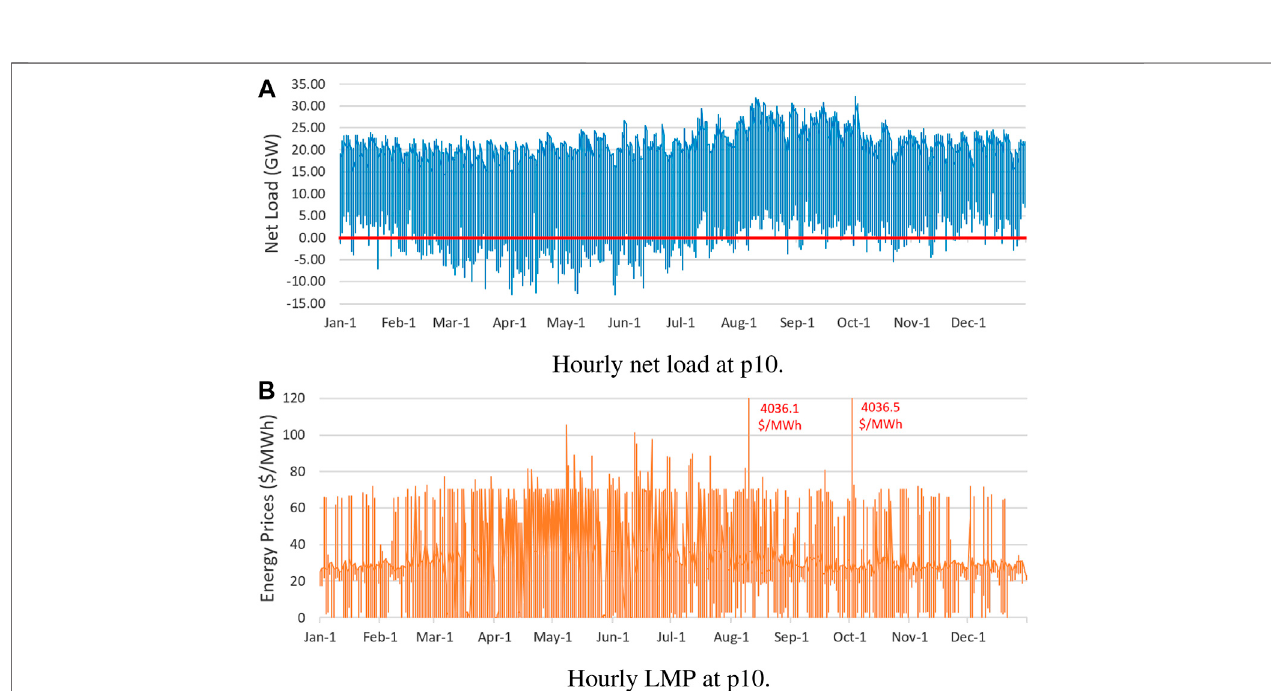
FIGURE 5 | Illustration of the hourly net load and locational marginal prices at p10 of the baseline operation in the 2050 WI. The red line in (7a) indicates zero net load, i.e., the electricity demand is equivalent to variable renewable energy availability.